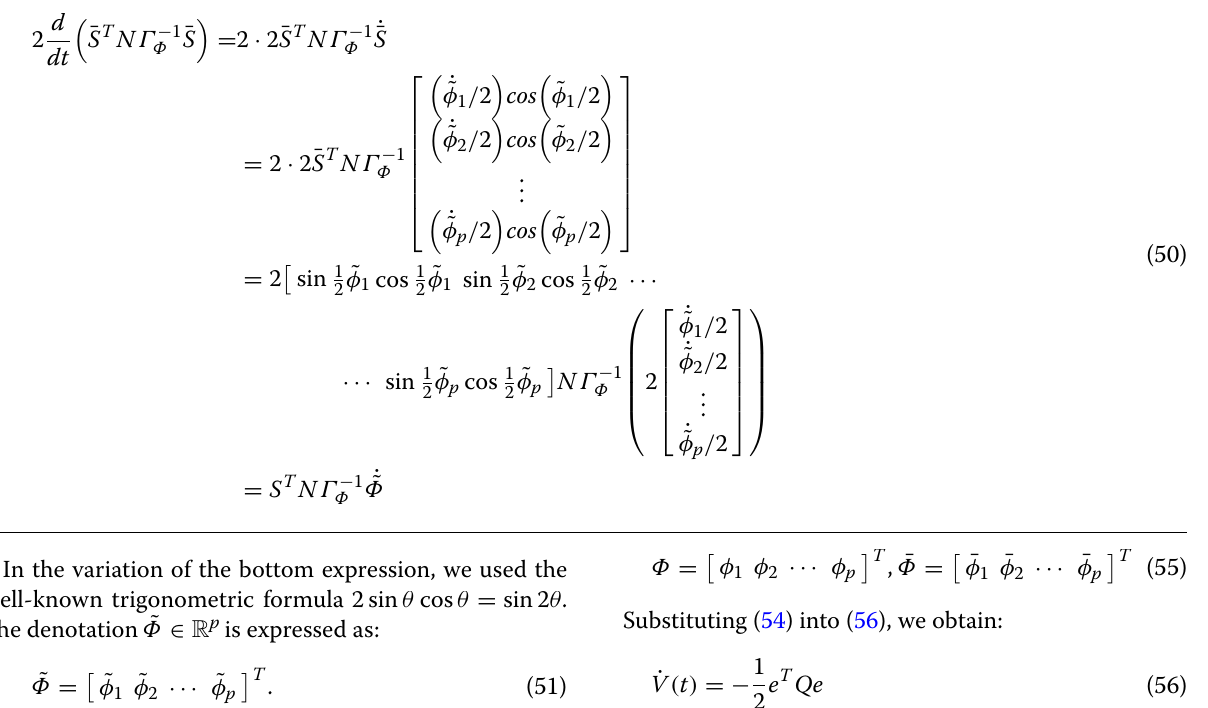
˙ V ≤ 0 , because matrix P is positive defi- It is clear that nite, as given in (45). Therefore, the scalar function V is positive definite and non-increasing for time t , and the signals e , �θ 1 , �θ 2 , �ξ are bounded, as is the case with adaptive parameters θ 1 , θ 2 , ξ from (16). Based on the fact that V is positive definite and non-increasing, as well as (56), there exists L which is a finite value, so e ∈ 2 . Moreover, the plant output x is bounded, and from that, reference model out- put x m is bounded in e = x − x m . From (42) and the fact that signals �θ 1 , �θ 2 , �ξ , x , r and the test signal term S T N τ are bounded, ˙ e is also bounded. By using Barbalat’s